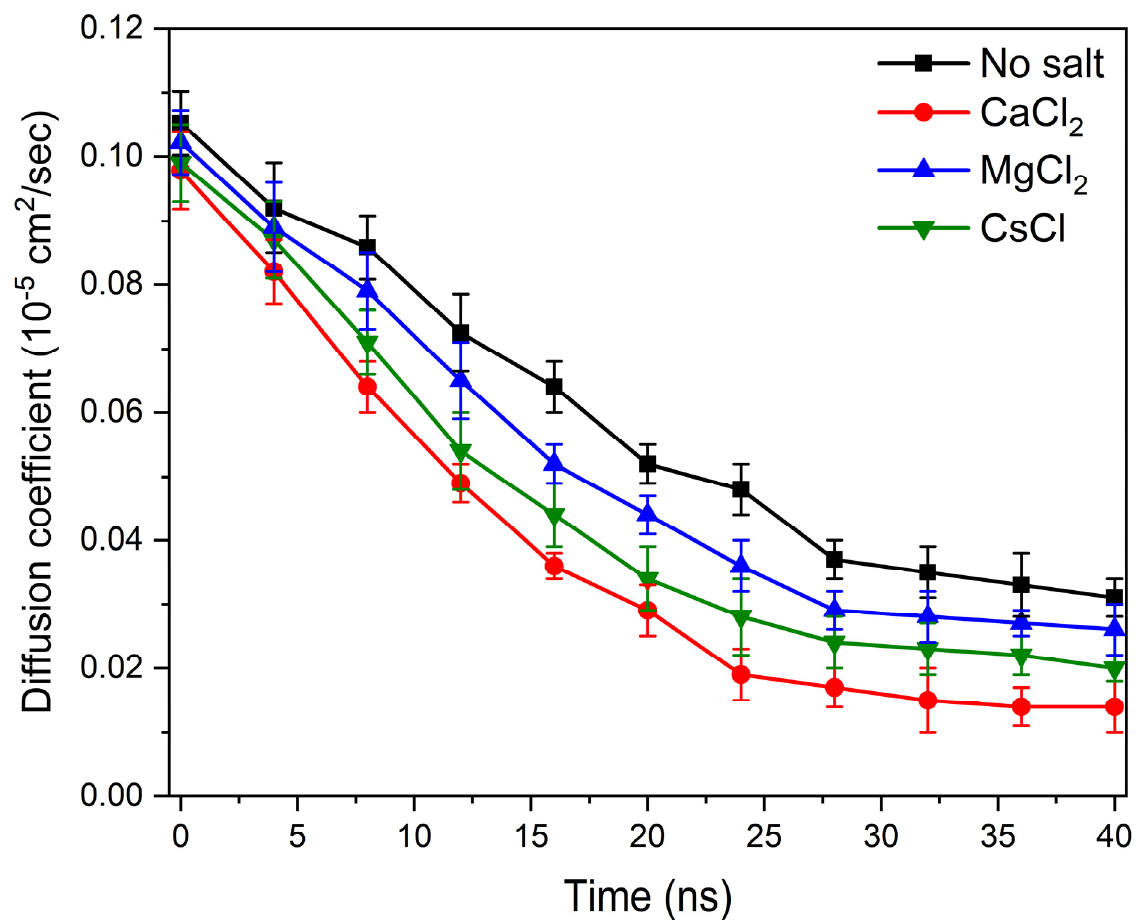
Figure 8. The self–diffusion coefficient of laponite suspensions determined from MD simulations as a function of the simulation time. The error bars of the data represent standard deviations based on simulations performed in triplicate.